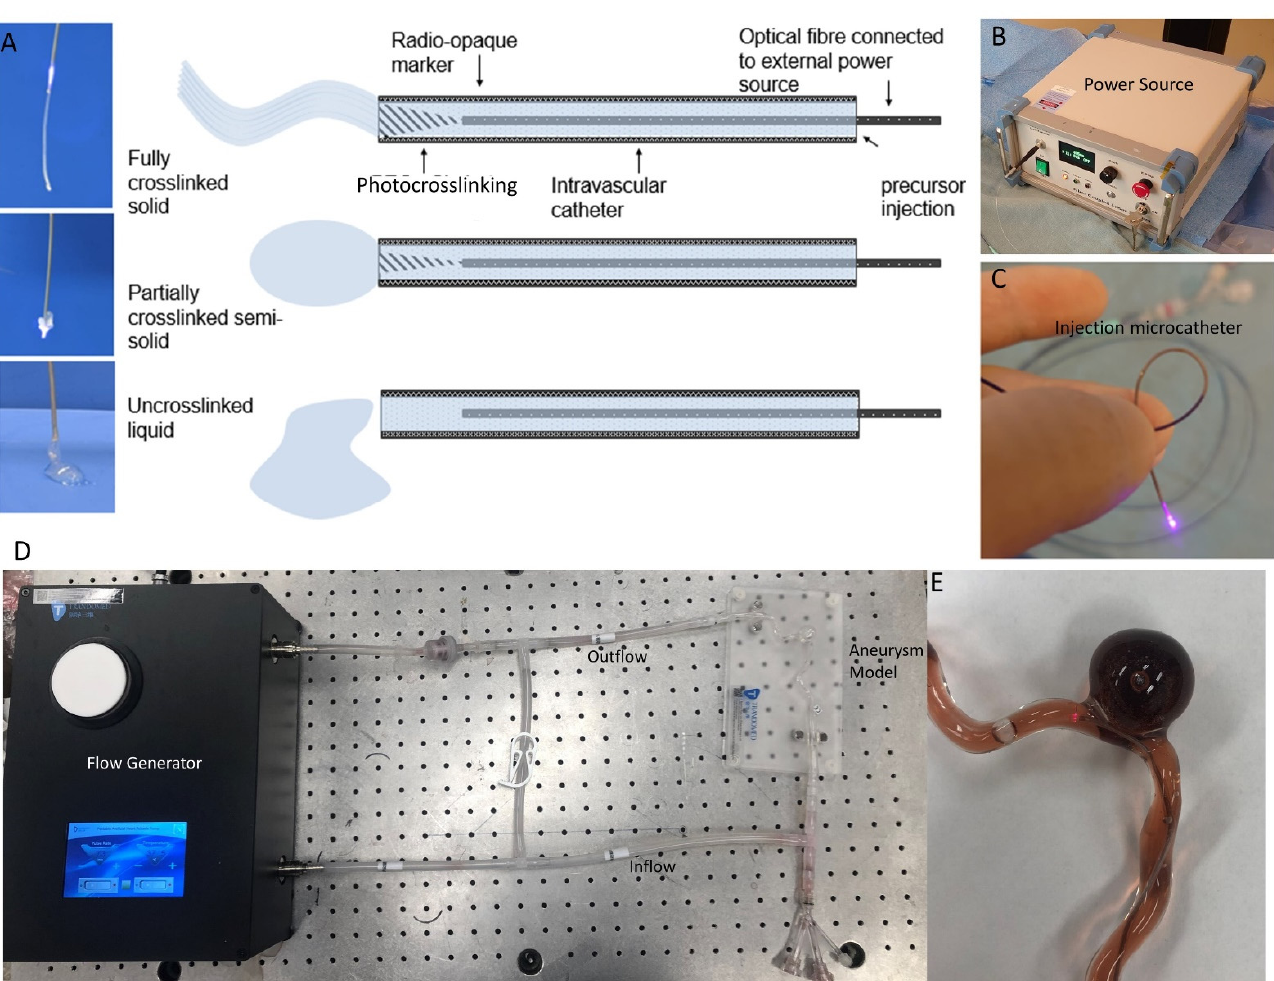
Figure 6. Pictorial representation of the different deposited forms of PHP based on variable photopolymerization ( A ) and the power source ( B ) with the injection microcatheter ( C ). The 3D-printed silicone with the pulsatile flow generator is shown ( D ) with a close-up view of the aneurysm model filled with circulating fluid ( E ).